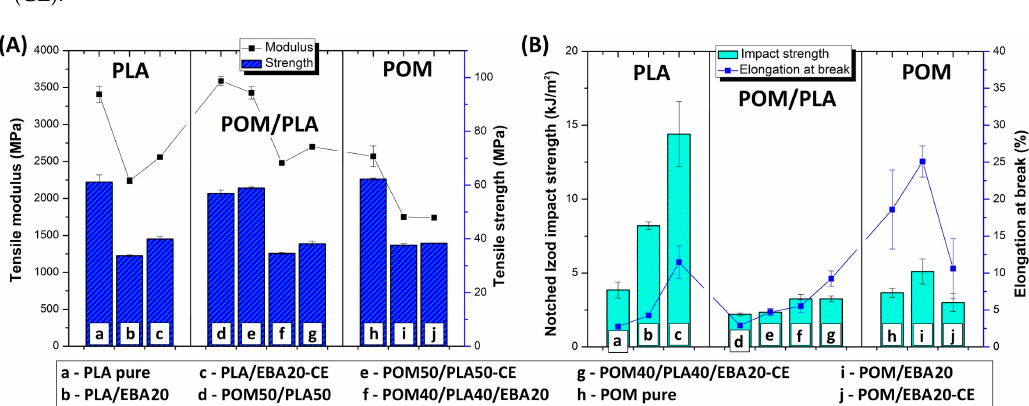
Figure 2. A comparison of the mechanical properties of the prepared blends from tensile and impact resistance measurements for the “as-molded” samples. ( A ) Tensile modulus and strength. ( B ) Elongation at break and impact strength. Results are grouped into PLA-, POM-, and POM/PLA-based samples modified using the ethylene/butyl acrylate/glycidyl methacrylate terpolymer (E/BA/GMA) elastomer (EBA) impact modifier and epoxy-functional styrene acrylic copolymer (ESA) chain extender (CE).